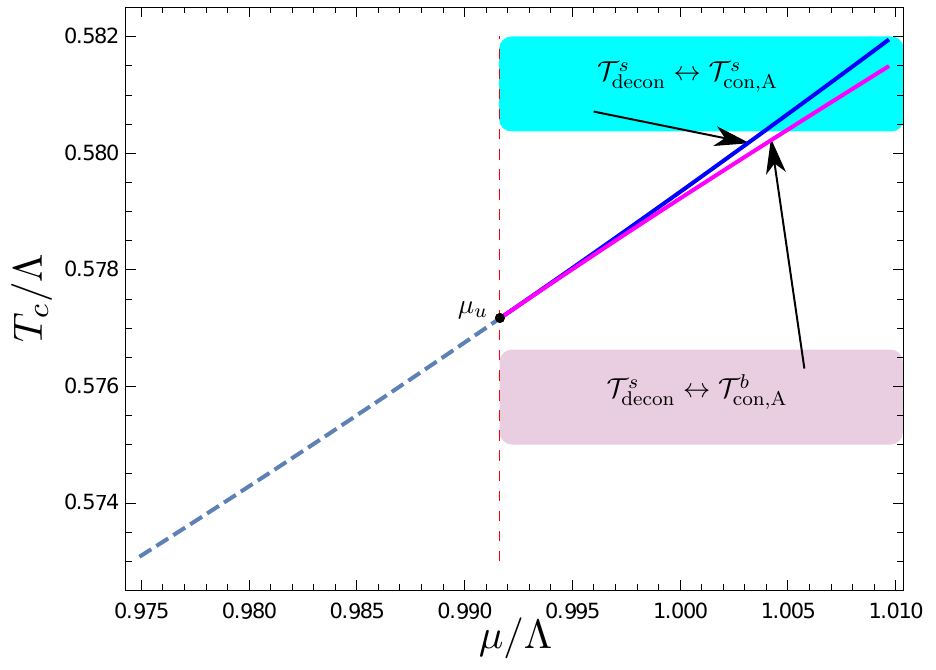
Figure 23 . The temperature T c of the confinement/deconfinement phase transitions between the different states in the cascading gauge theory. Magenta curve represents the analog of the Hawking- Page phase transition between the Klebanov-Tseytlin black holes and the the conifold flux geometries. The deconfined states are the preferred ones for T > T c